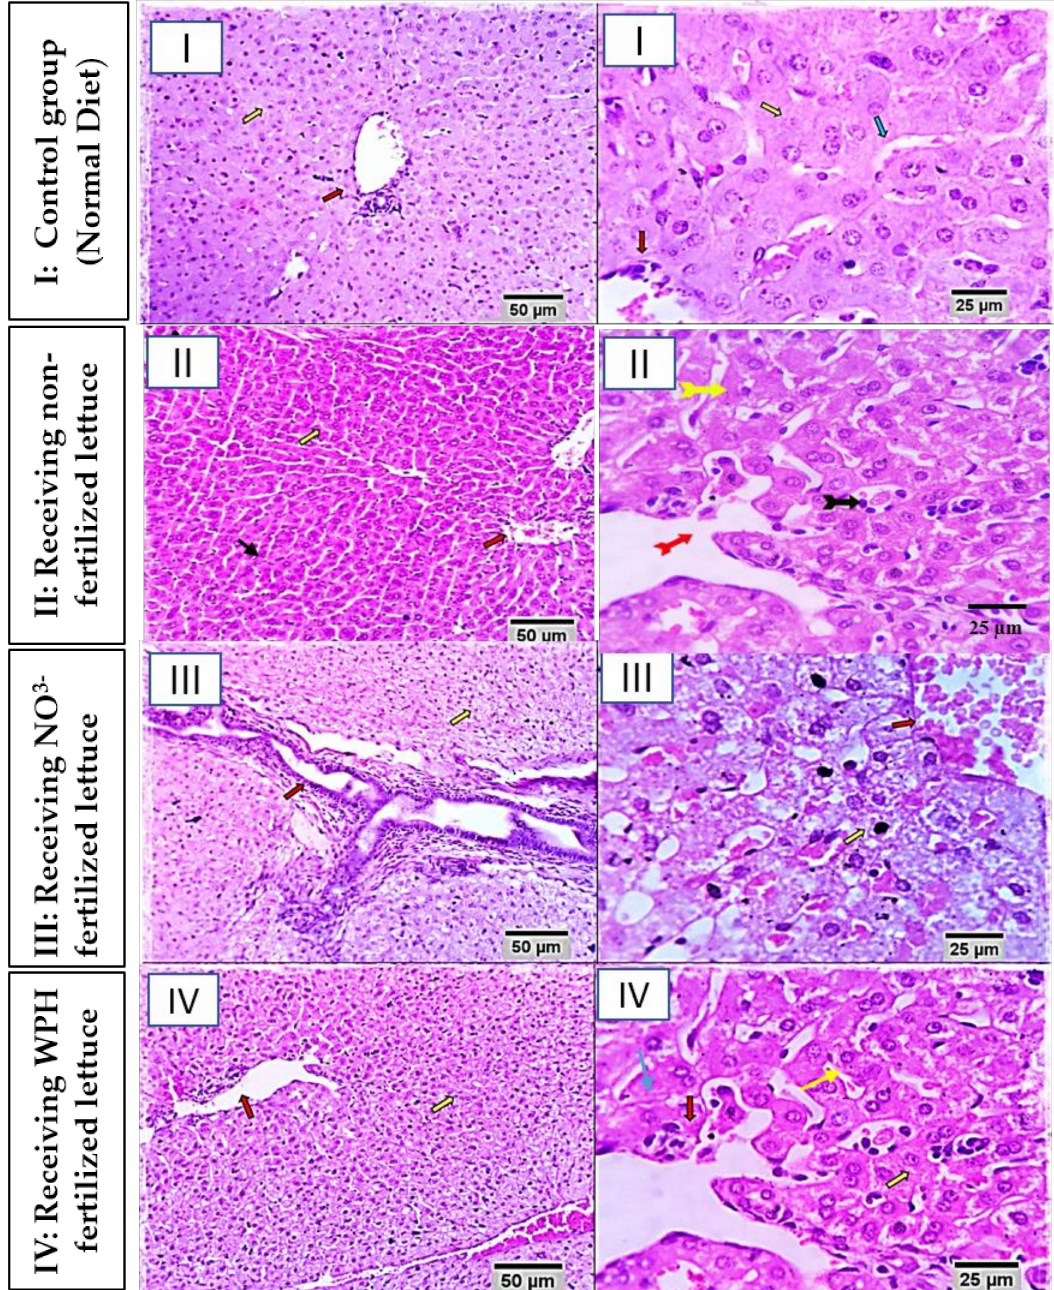
Figure 1. Photomicrograph from liver of different rabbit groups (I, II, III and IV) at 25 µ m and 50 µ m scale bars. Group I (healthy control, not receiving any supplement), is showing preserved lobular arrangement, hepatic cords orientations (yellow arrows), portal tirades structural components (red arrows), sinusoids, Von–Kuffer cells (green arrows), and stroma. Group II is showing normal hepatic parenchyma with preserved hepatic cords arrangement (yellow arrows), portal triads structures (red arrows), and sinusoids (black arrow). Group III (rabbits receiving nitrate-fertilized lettuce) is showing moderate portal and interstitial aggregations of round cells, mostly lymphocytes and plasma cells (orange arrow). Bile ducts appear moderately hyperplastic and to be suffering from chronic obstructive cholangitis (red arrow). Moderate portal vascular congestion and sinusoidal dilatation are seen (red and black arrow). Periportal hepatocellular degenerative changes (mostly hydropic degeneration) and early necrotic changes are seen (yellow arrows). Group IV is showing degenerative changes in a few hepatocytes. Most of the degenerative changes were within the cloudy swelling and hydropic types (yellow arrows). Portal tirades showed mild aggregation of lymphocytes and plasma cells (red arrows). Focally dilated hepatic sinusoids are seen (blue